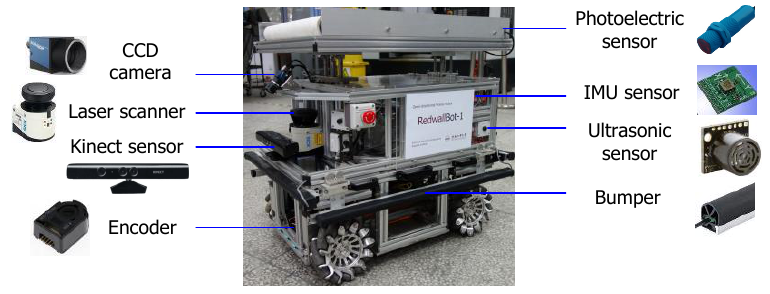
Figure 5. Assignment of the on-board sensors.